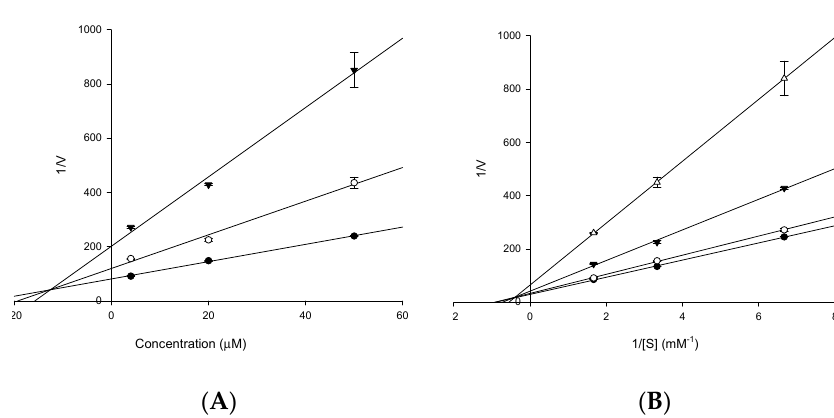
Figure 3. Dixon plots and Lineweaver-Burk plots for acetylcholinesterase (AChE) inhibition by 3 . The results showed the e ff ects of presence of di ff erent concentrations of the substrate (0.6 ( ● ), 0.3 ( ○ ), and 0.1 mM ( ▼ )) for ( A ) and the effect of presence of different concentration of 3 (0 ( ● ), 4 ( ○ ), 20 ( ▼ ), and 50 µM ( △ )) for ( B ).